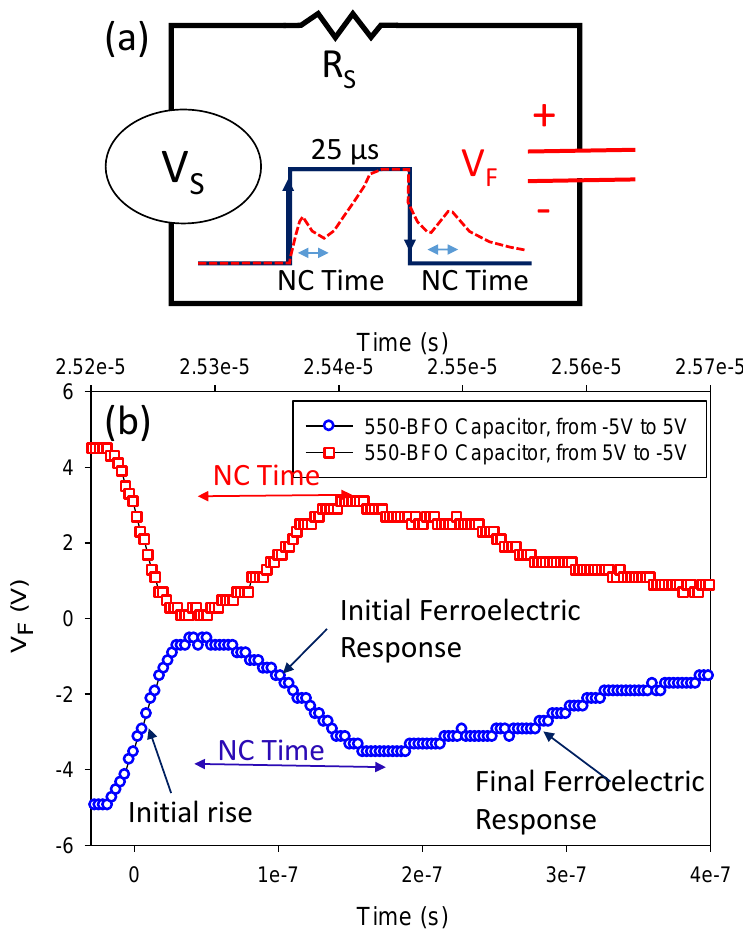
Figure 3. ( a ) Schematic diagram of experimental setup where the BFO capacitor is connected in series with a resistor (RC circuit). The pulse time is 25 μs. In the zoom, the solid line represents the input Vs signal and the dotted line represents the output voltage of the BFO capacitor. ( b ) Transient response of V F for BFO capacitor. The NC time is 0.160 μs from −5 V to 5 V and 0.136 μs from 5 V to −5V.